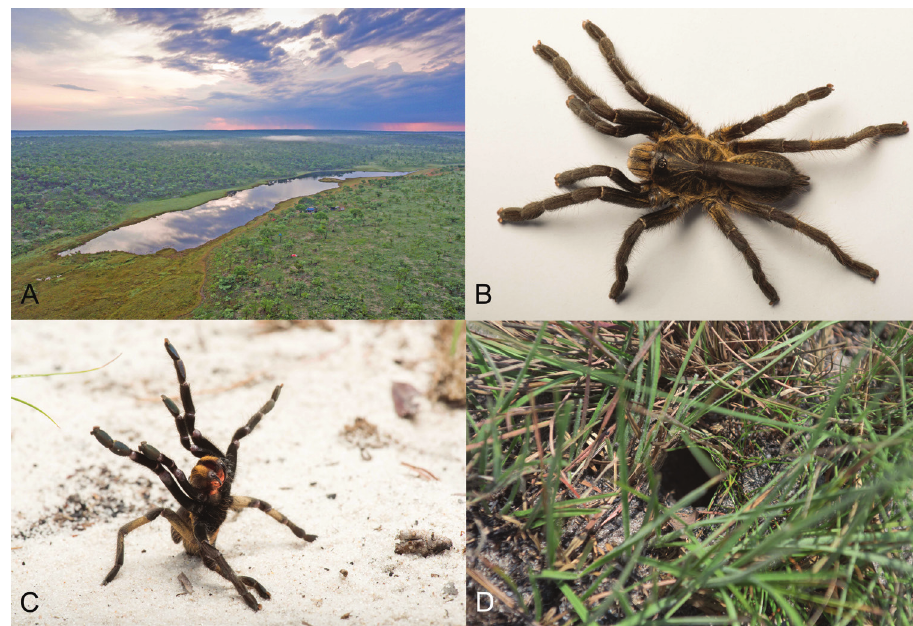
Figure 2. Habitat, burrow and live habitus of Ceratogyrus attonitifer sp. n. in south-eastern Angola. A Aerial view of habitat at the type locality showing a dambo (wetland) amongst miombo ( Brachystegia ) woodland. The expedition campsite is to the right of the dambo. Specimens were collected primarily along the margins of the wetland area B live habitus, dorsal, showing full size of the foveal protuberance in life C specimen in defensive posture typical for baboon spiders; background is white sand at the type locality D burrow entrance amongst grass tussocks; entrance approximately 2cm